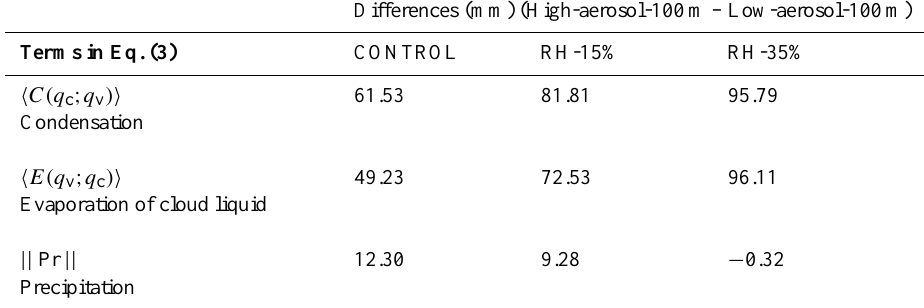
Table 5. Domain-averaged differences in the accumulated sources and sinks of precipitation, retained in the approximated Eq. (3) between the high-aerosol-100m and low-aerosol-100m